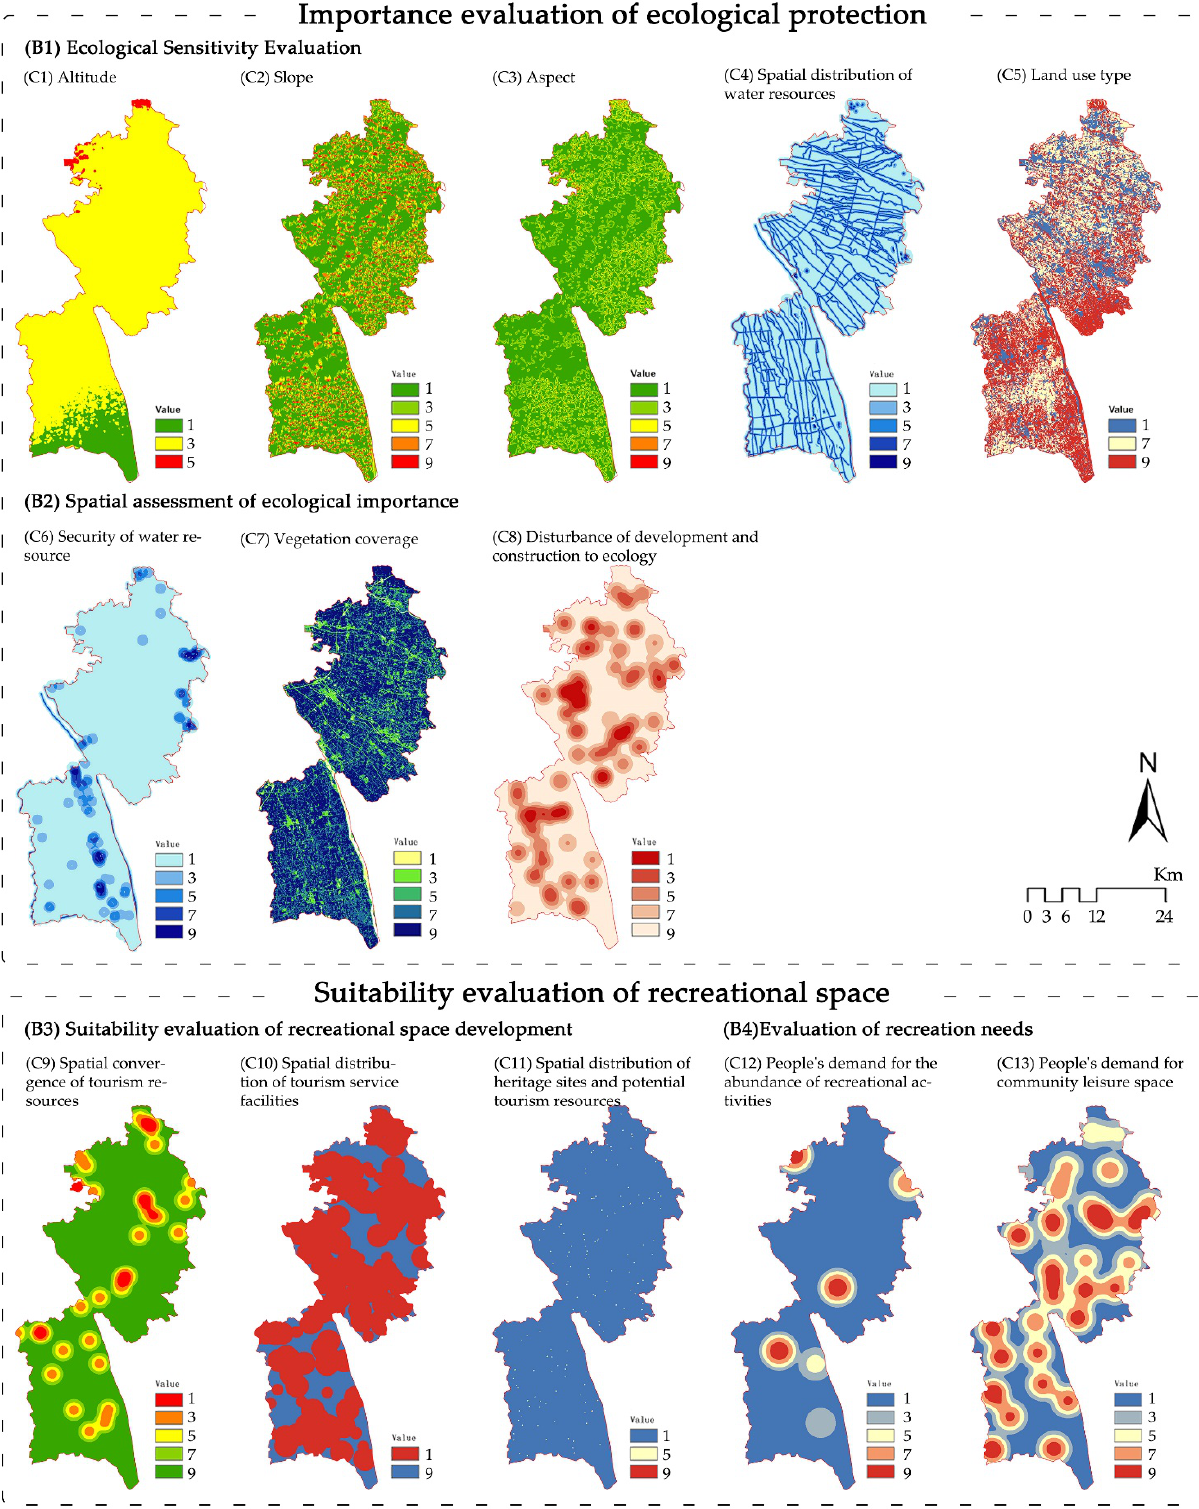
Figure 3. Spatial analysis of a single